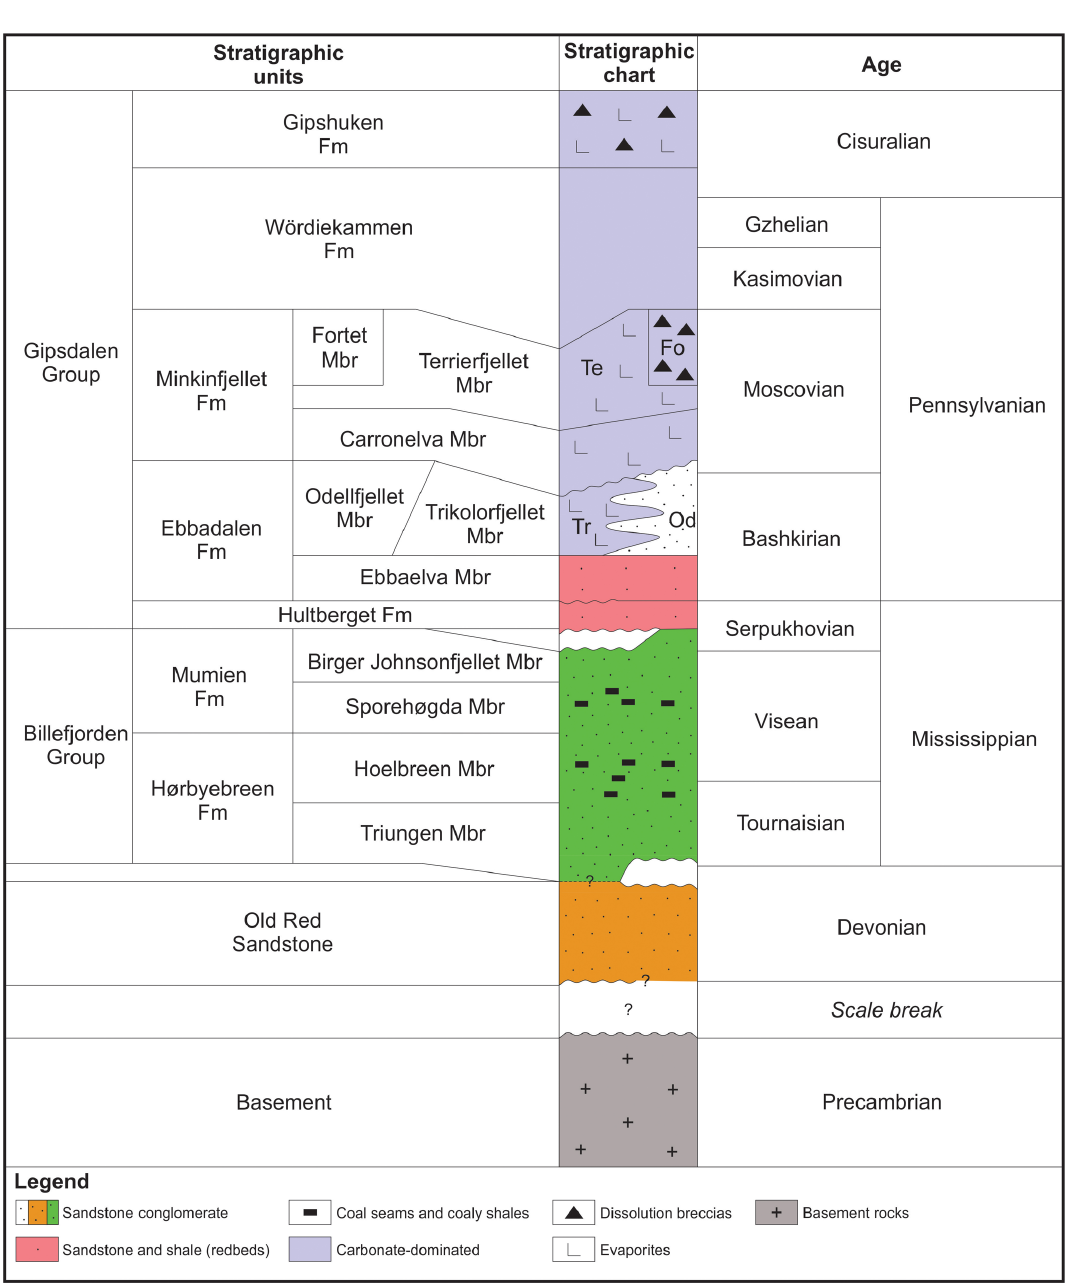
Figure 2. Lithostratigraphic chart of late Paleozoic sedimentary rocks in central Spitsbergen. The chart is based on descriptions by Gee et al. (1952), McWhae (1953), Playford (1962), Cutbill and Challionor (1965), Holliday and Cutbill (1972), Cutbill et al. (1976), Johannessen (1980), Gjelberg (1981, 1984), Gjelberg and Steel (1981), Johannessen and Steel (1992), Lønøy (1995), Dallmann (1999), Braathen et al. (2011), and Scheibner et al.